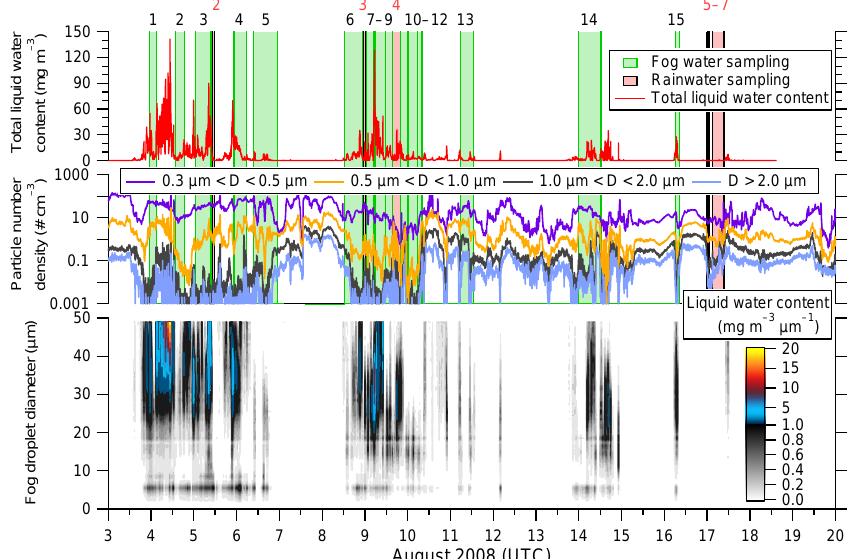
Fig. 3. Temporal variations of total LWC, particle number densities for aerosols in four size groups, and LWC for each of the 40 droplet size classes during the cruise. The green and pink shaded areas indicate sea fog water and rainwater sampling durations, respectively. The black and pink numbers indicate sea fog and rainwater sample number, respectively. When sea fog and rain events occurred simultaneously, only rainwater sample was collected. Then that sample was considered as a rainwater sample (i.e. rainwater sample number 3 and 4). Since rainwater sample number 1 was collected on 30 July, it was not presented here.